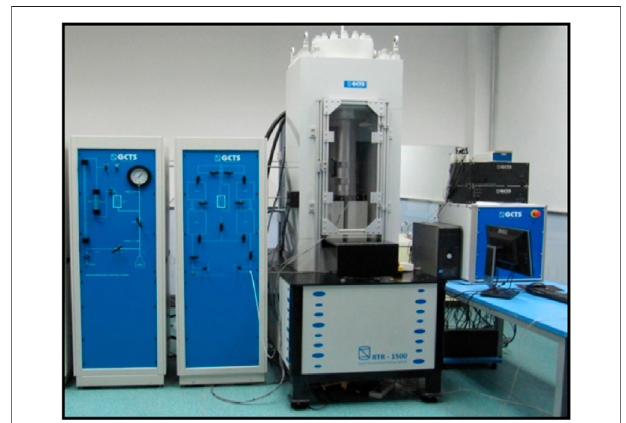
FIGURE 2 | Rock physics test system in rock mechanics